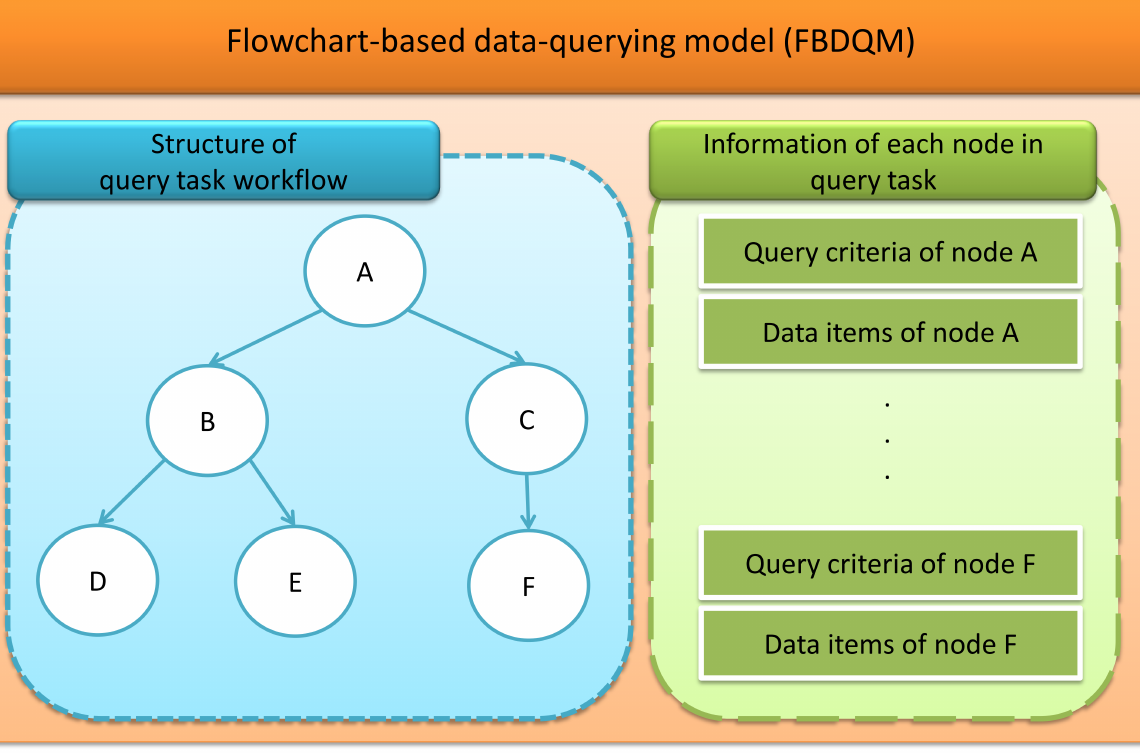
Figure 3. The flowchart-based data-querying model (FBDQM) containing the structure of query task workflow and the information of each node in the query